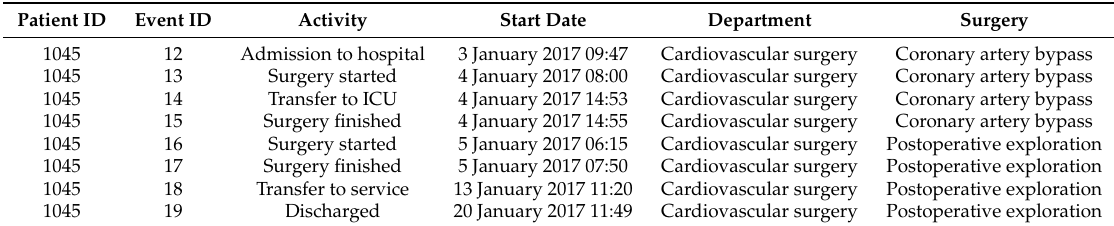
Table 5. A fragment of an event log including (for patient 1045) who are diagnosed with atherosclerotic heart disease: event ID, start date, activity, department, and surgery.